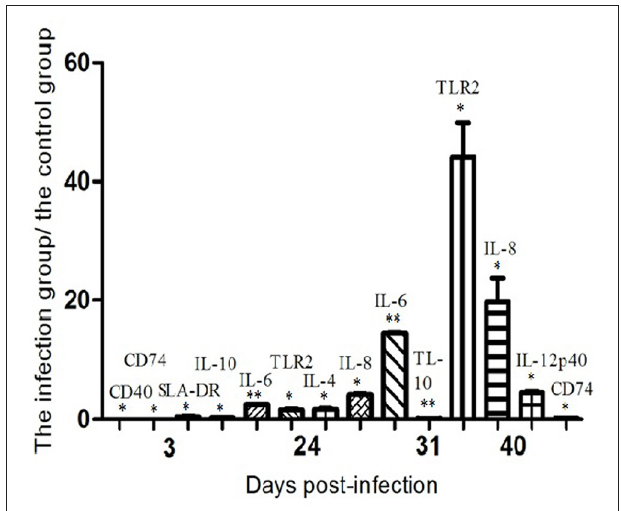
FIGURE 5 | The mRNA expression profiles of functional molecules in peripheral blood mononuclear cells or alveolar macrophages from P1-infected and healthy piglets as determined by semiquantitative RT-PCR. For each molecule, the amounts of RT-PCR products were normalized to the values obtained with β -actin, used as an internal standard for each sample. The relative levels of the molecules mRNA expression are expressed as the mean fold increase of the virus-infected groups vs. control animals, error bars represent standard deviations. Statistical analysis was performed by means of the two-tailed unpaired Student’s t -test. * P < 0.05, ** P <